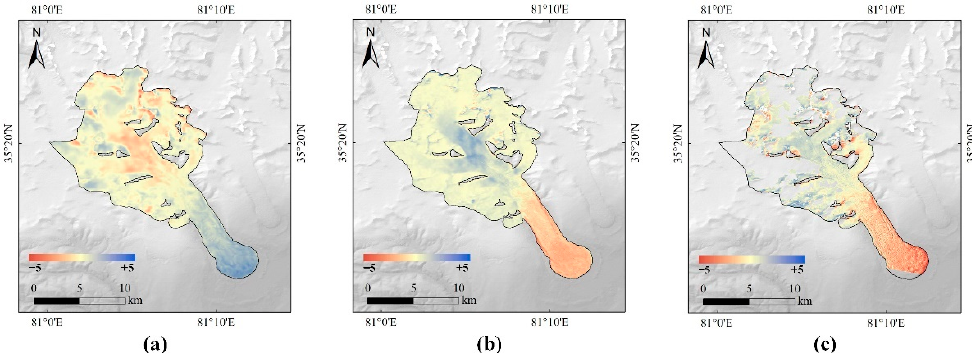
Figure 2. Observed surface elevation changes (m yr − 1 ) over the Chongce Glacier during the periods of 1970–2000 ( a ), 2000–2012 ( b ), and 2012–2018 ( c ). Note that the coverage of the ZY-3 images (see Figure 1) resulted in the data missing in the southwest part ( c ). Table 2. Estimated average glacier elevation change and glacier mass balance between 1970 and 2018 over the Chongce Glacier.